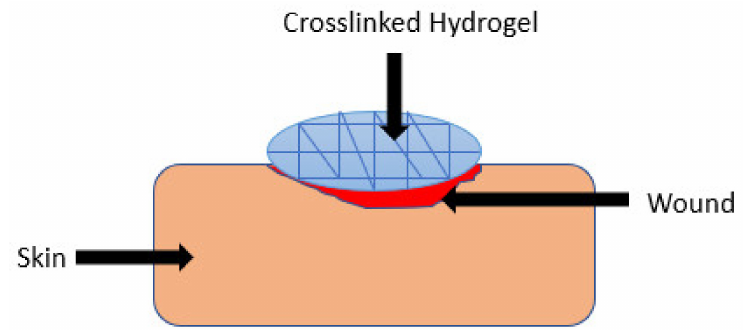
Figure 5. Crosslinked Hydrogel on Skin